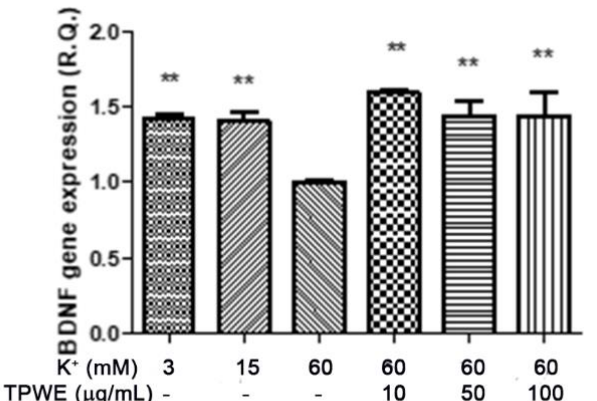
Figure 6. The stimulating effect induced by Tanacetum parthenium water extract (TPWE: 10–100 µ g/mL) on the brain-derived neurotrophic factor (BDNF) gene expression (R.Q. = relative quantification) in isolated cortexes challenged with K + 60 mM. ANOVA, p < 0.0001; ** p < 0.01 vs. the K + 60 mM